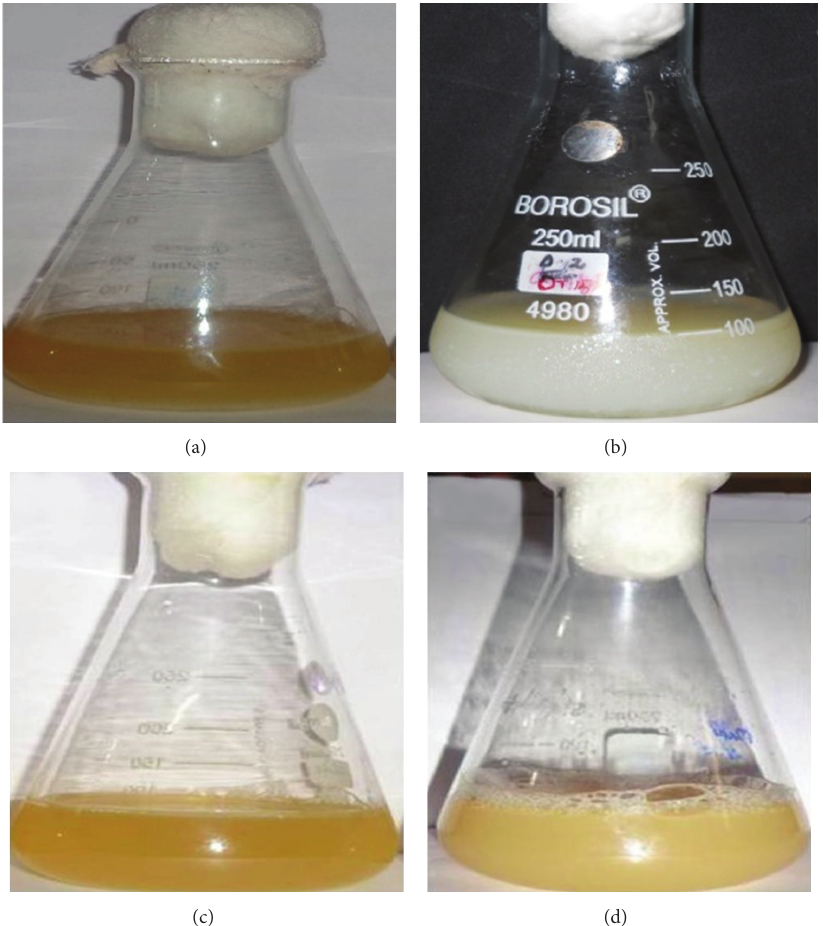
Figure 1: Biosynthesis of CdS and ZnS nanoparticles: (a) and (c) culture supernatant, (b) and (d) with addition of metal ions 24-hour